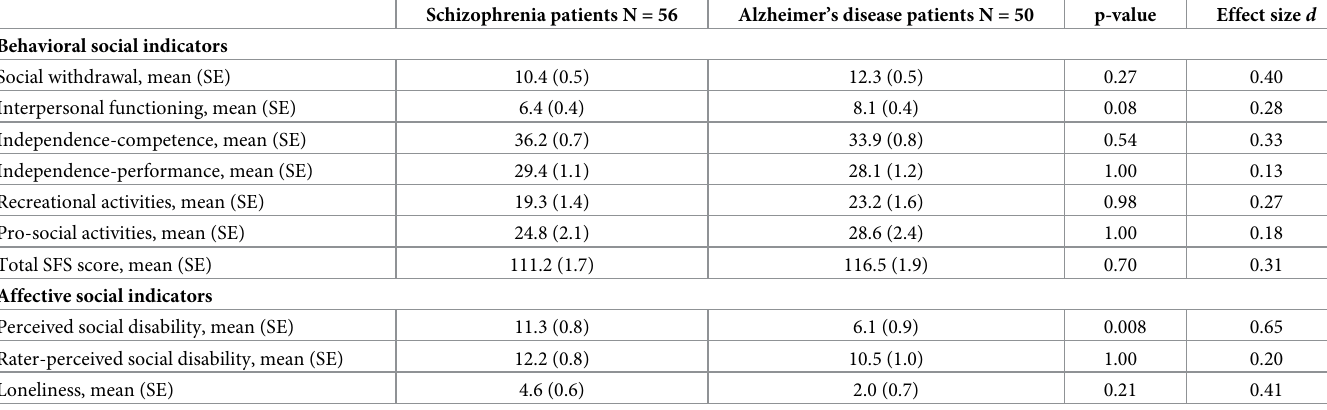
Linear regression analyses (Table 5) examined the association between clinical characteris- tics (severity of disorder, mood, positive/negative affect) and social functioning indices among SZ and AD patients adjusted for aforementioned covariates. Overall, only a few predictors were found to associate strongly with overall disease severity. More AD symptomatology was associated with fewer prosocial activities ( β = -0.400, p = 0.014). More negative SZ symptom- atology was associated with less interpersonal functioning ( β = -0.330, p = 0.010), and more Table 4. Mean adjusted † social functioning scores across disorders with effect sizes (N =